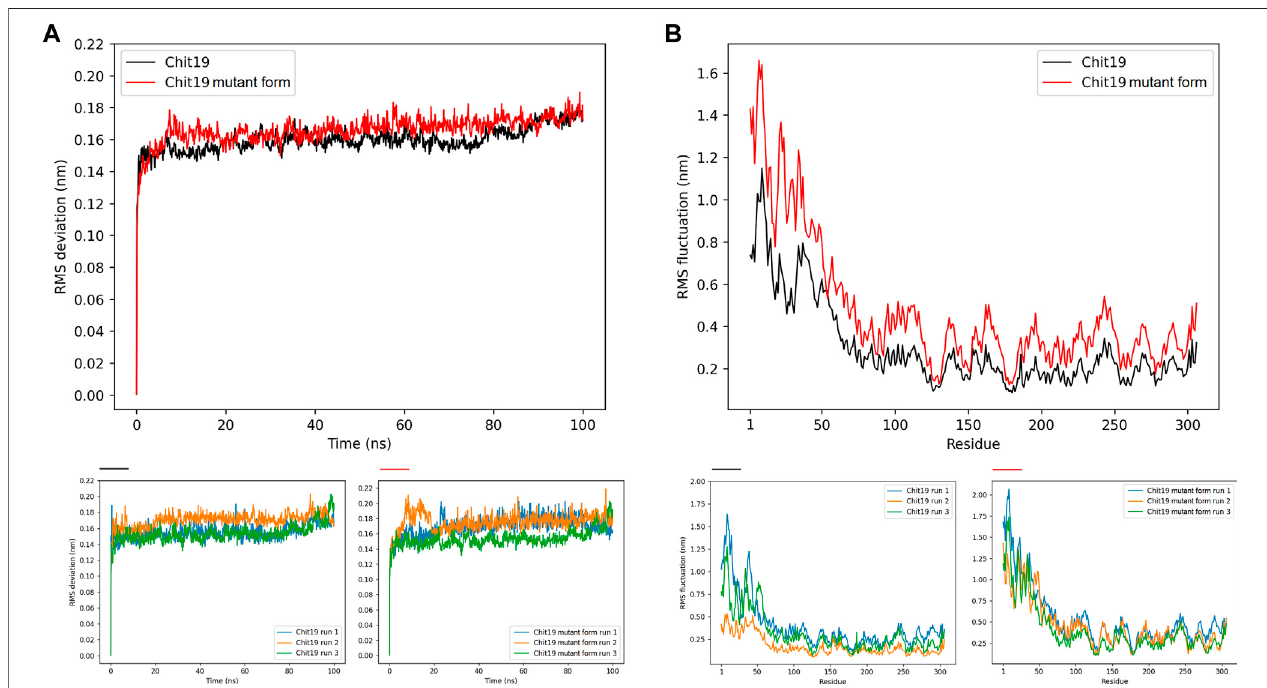
FIGURE 4 | (A) Backbone RMSD averaged for three runs for positions 62 – 306 (excluding ChBD-linker region as the linker region had high fl uctuations throughout thesimulation runs)ofChit19wild-type(black)andvariantC191A/C231S/C286T(red)oversimulationtimeinns. (B) RMSFperresidueaveragedforthreerunsofall306 residues of Chit19 wild-type (black) and variant Chit19- C191A/C231S/C286T (red). Residue pos. 1 – 39 de fi ne the ChBD and pos. 59 – 84 the Chit19 linker region. Smaller diagrams below indicate RMSD (left diagrams) and RMSF (right diagrams) values for Chit19 wild-type and variant for each single simulation